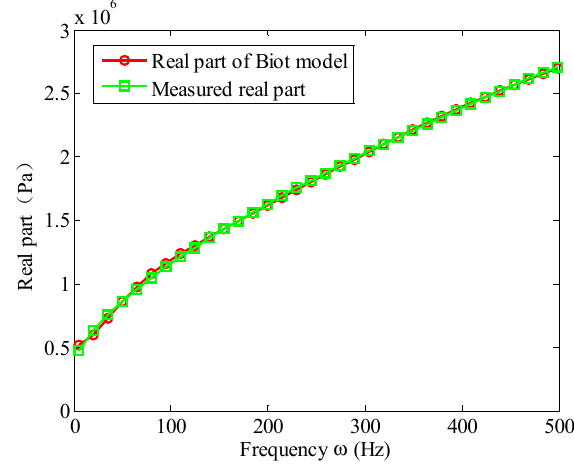
Table 2. Biot model parameters of the viscoelastic material, 30 °C.